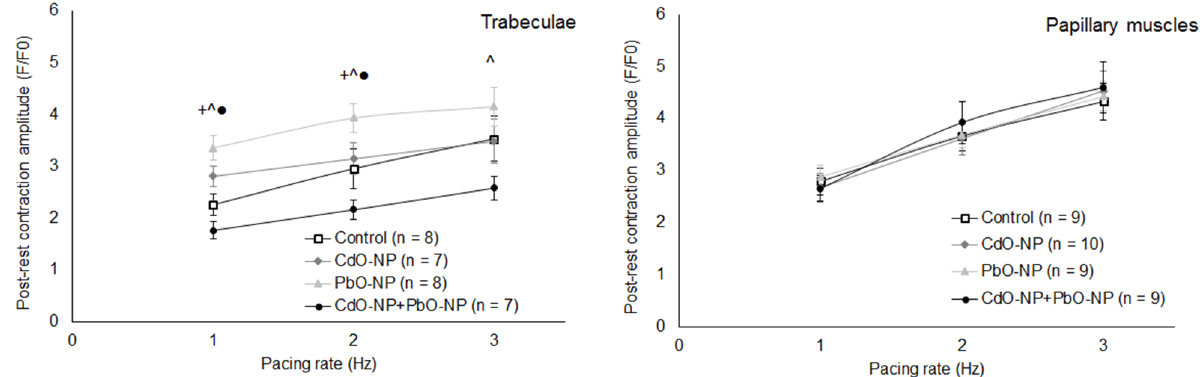
Figure 9. The relationship between post-rest potentiation (assessed as ratio between the amplitudes of the first twitch after 30 s rest and the pre-rest twitch) and pacing rate, obtained for isolated trabeculae (left panel) and papillary muscles (right panel). The pacing rate is varied between 1 and 3 Hz. The muscles are paced at 0.95 L MAX . Data are shown as mean ± S.E. There are significant differences: +—PbO–NP vs. Control, ● —CdO–NP + PbO–NP vs. CdO–NP, ^—CdO–NP + PbO–NP vs. PbO–NP ( p < 0.05, Mann–Whitney U -test).